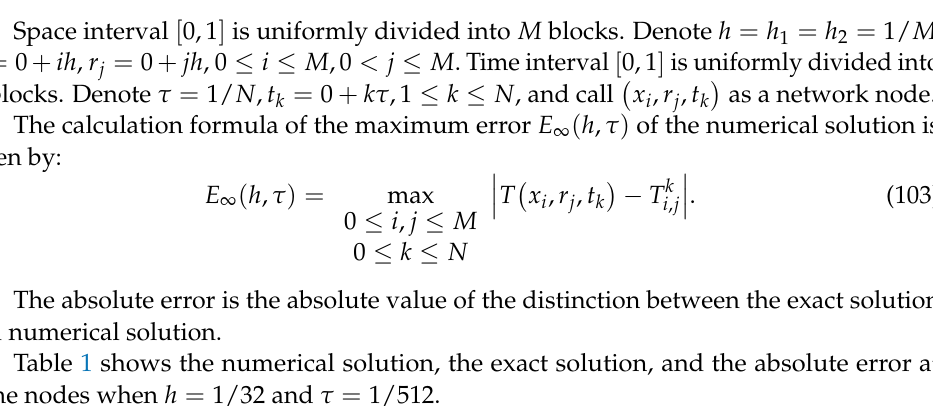
Table 1. Numerical solution, exact solution, and absolute error at some nodes ( h = 1 / 32 , τ = 1 / 512 ) . ( x , r , t ) Numerical